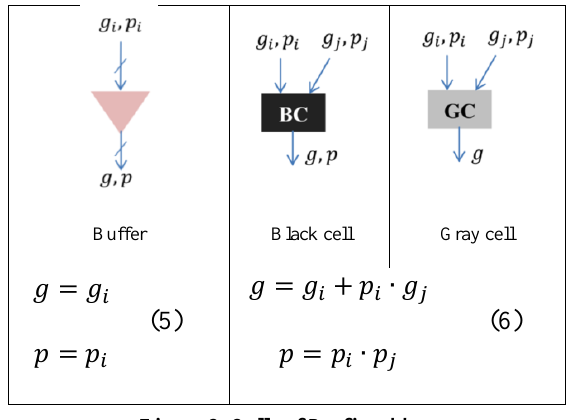
Figure 3. Cells of Perfix adder.